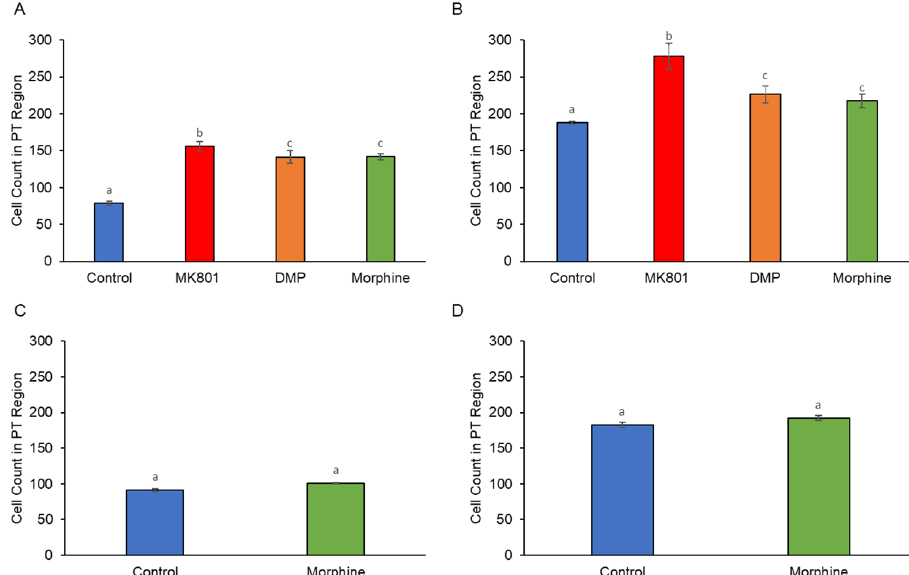
Figure 6. Effects of ( A ) short-term (F (3, 28) = 19.32, p = 0.00), ( B ) long-term (F (3, 28) = 10.74, p = 0.00) exposure to MK801, DMP, and morphine, and after withdrawal of ( C ) short-term (t (14) = 18.78, p = 0.00) and ( D ) long-term (t (14) = 6.33, p = 0.02) morphine treatment on cell counts in the PT region of the zebrafish larvae brain. Data expressed as mean ± SEM, n = 8. Different alphabets indicate statistically significant values, p < 0.05. Drug abbreviation: DMP, domperidone. Other abbreviation: PT, posterior tuberculum.